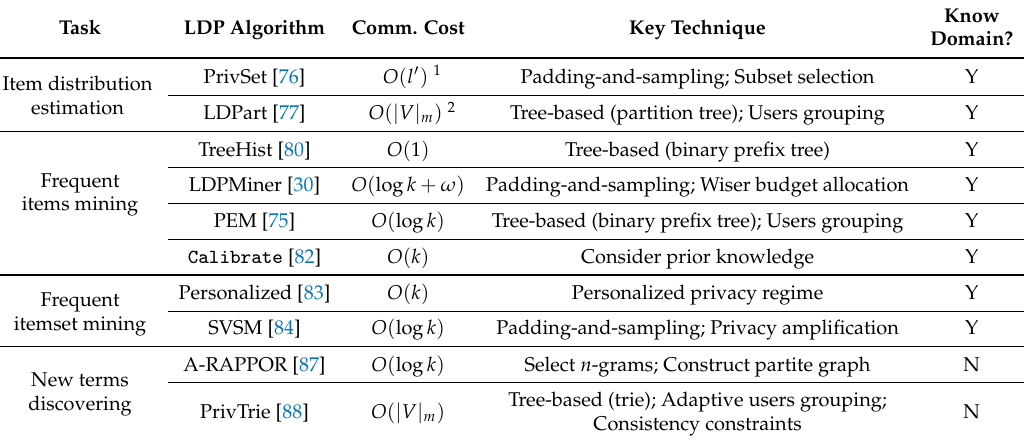
Table 6. Comparisons of frequency estimation mechanisms for set-valued data with